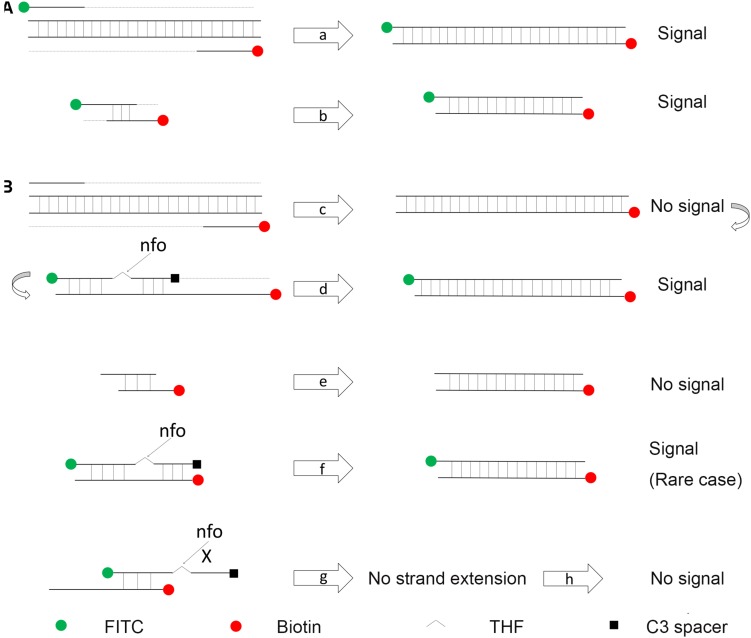
Schematic representation of a specially designed probe that reduces false-positive signals from primer–dimers. (A) In a typical RPA amplification, both the amplification products (a) and the primer–dimers (b) can give positive signals. (B) In the modified RPA reaction, amplification of the target DNA from the primer pair does not give the positive signal (c). This amplification product goes through another round of amplification guided by the probe to give a positive signal (d). Primer–dimers in the modified RPA reaction do not give the positive signal (e). Primer–probe complexes for most of the time do not give the positive signal (g). Only in a rare case that the primer and the probe have a good matching of the bases flanking the [THF] site, the complex can give the positive signal (f). DNA strands are presented as horizontal lines, and the base pairings are indicated as short vertical lines between the DNA strands. Anticipated amplification of the DNA strands is indicated as dotted lines. The nfo cleavage is indicated by arrows, and blocked cleavage is indicated by an “X.” Labels and modifications on DNA are indicated with different shapes and colors, with the legends given at the bottom of the figure.